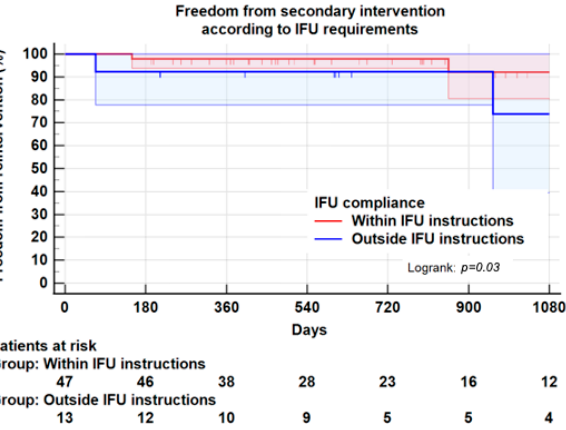
Figure 4. Kaplan–Meier plot for freedom from secondary intervention according to compliance with IFU instructions. At 3 years, freedom from secondary intervention was 92.1 ± 5.9% in patients compliant with IFU instructions, and 73.8 ± 15% in patients non-compliant with IFU instructions, p = 0.03.